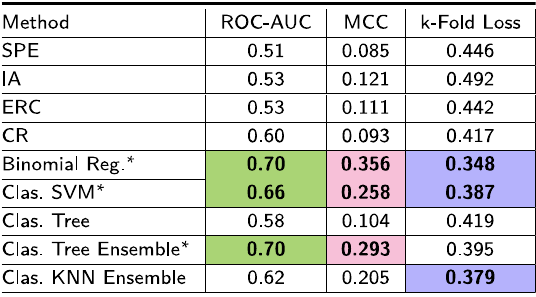
Table 6: Performance measures: the receiver operating character -